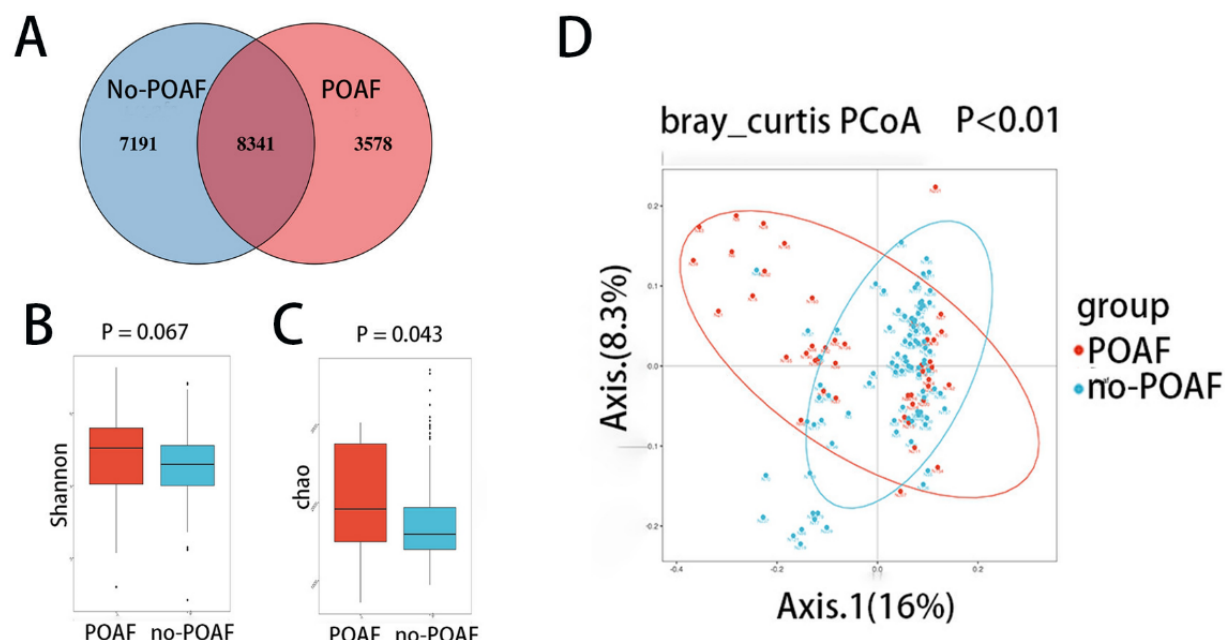
Figure 1. The diversity of the fecal microbiota. ( A ) OTU Venn diagram: blue circle indicates the number of OTUs unique to no-POAF patients, red circle indicates the number of OTUs unique to POAF, and the overlapping part shows the number of OTUs shared by the two groups. ( B ) The Shannon index in POAF and non-POAF patients. ( C ) The Chao1 index in POAF and non-POAF patients. ( D ) The β diversity of POAF and non-POAF patients based on the PCoA analysis. Samples were used in each analysis. Kruskal–Wallis H test was used in the comparison of the Shannon index and Chao1 index. In the comparison of PCoA analysis, the Adonis test was used.